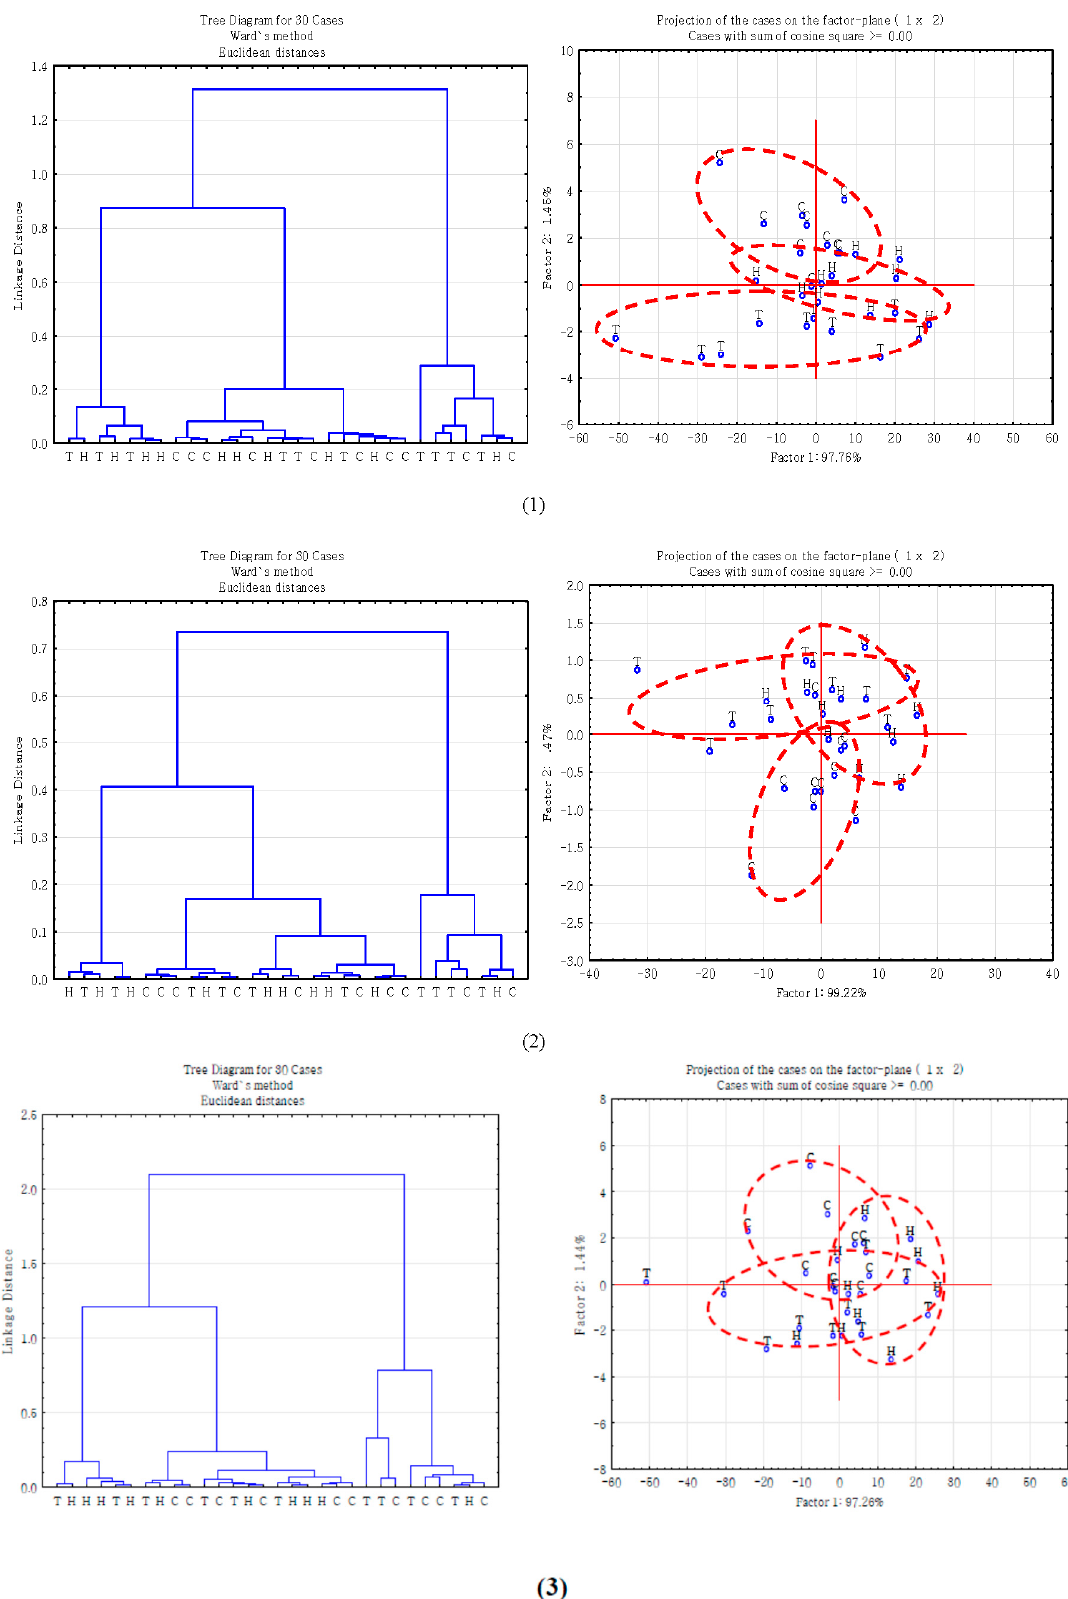
Figure 1. Cont. Figure 1.